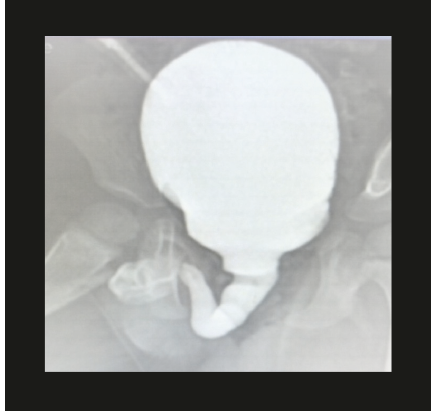
Figure 3: VCUG (elongated, dilated urethra) (case 1).